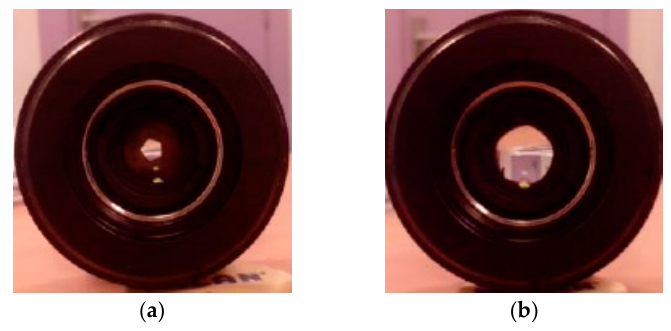
Figure 7. Lens aperture according to the f-number: ( a ) minimum with 16; ( b ) maximum with 1.9.